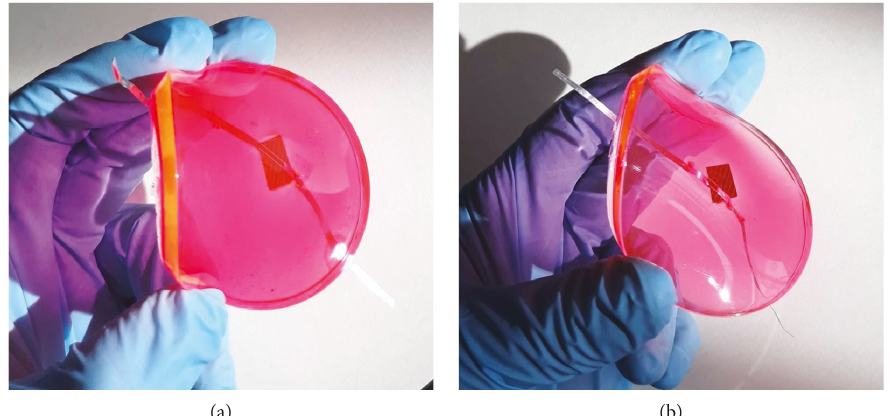
Figure 2: Finished LSC devices. The bulk-doped LSC (a) has dye evenly distributed throughout the waveguide. The thin- fi lm LSC (b) has a thin ( ~ 0.26 mm) layer of concentrated dye applied to the bottom surface. The front-facing solar cell can be seen in the center of both fl exible